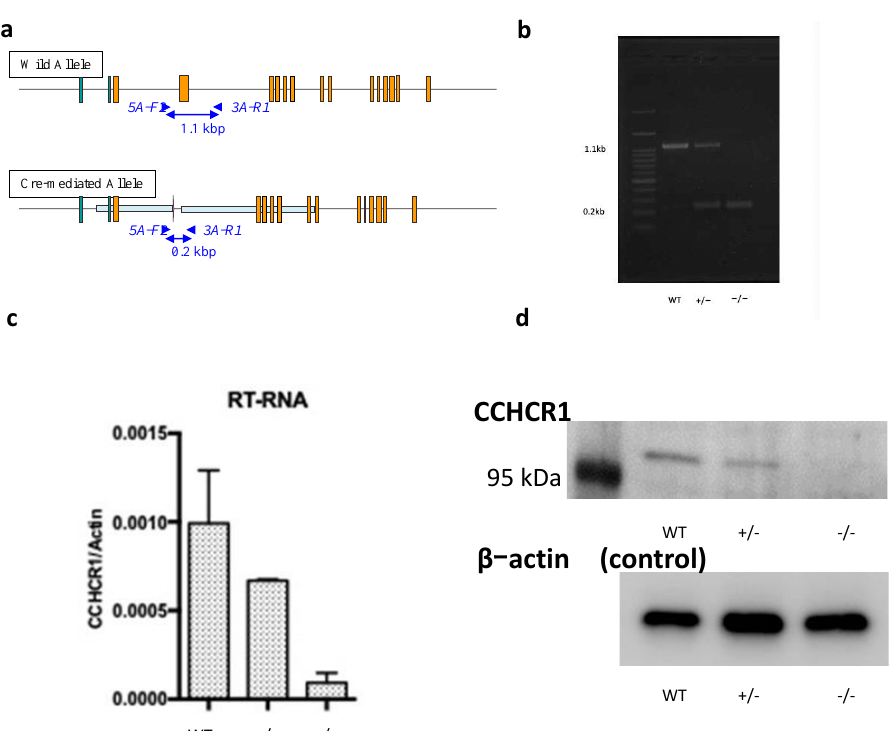
Figure 1. Generation of cchcr1 − / − mice. ( a ) Exon 4 was deleted through the loxP site in cchcr1 . ( b ) Genotypes were identified by PCR of tail tips. The samples were loaded as follows: first lane, molecular weight marker; the WT band is at 1.1 kbp; the two cchcr1 +/ − bands are at 1.1 kbp and 0.2 kbp; and the cchcr1 − / − band is at 0.2 kbp. ( c ) The expression of cchcr1 in WT mice, cchcr1 +/ − mice, and cchcr1 − / − mice was examined by RT-PCR. β -actin was used as an internal control. ( d ) Western blot showing the expression of cchcr1 in skin tissue lysates from WT, cchcr1 +/ − and cchcr1 − / −